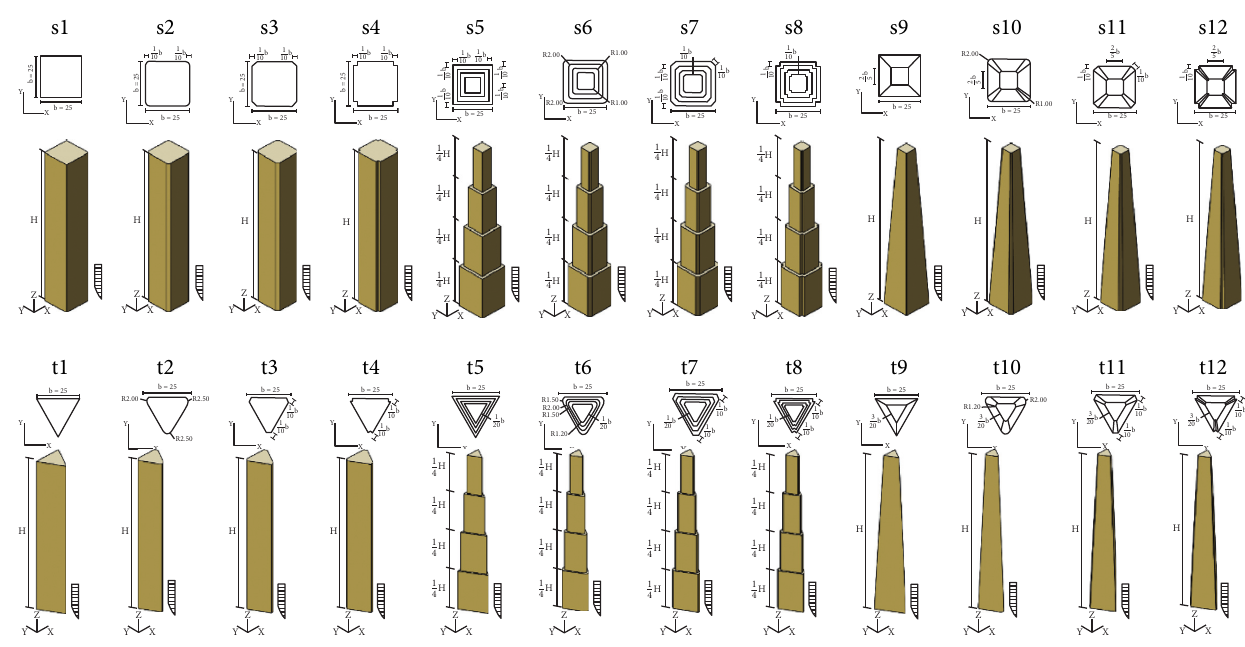
Table 1: Schematic of building models and model IDs.